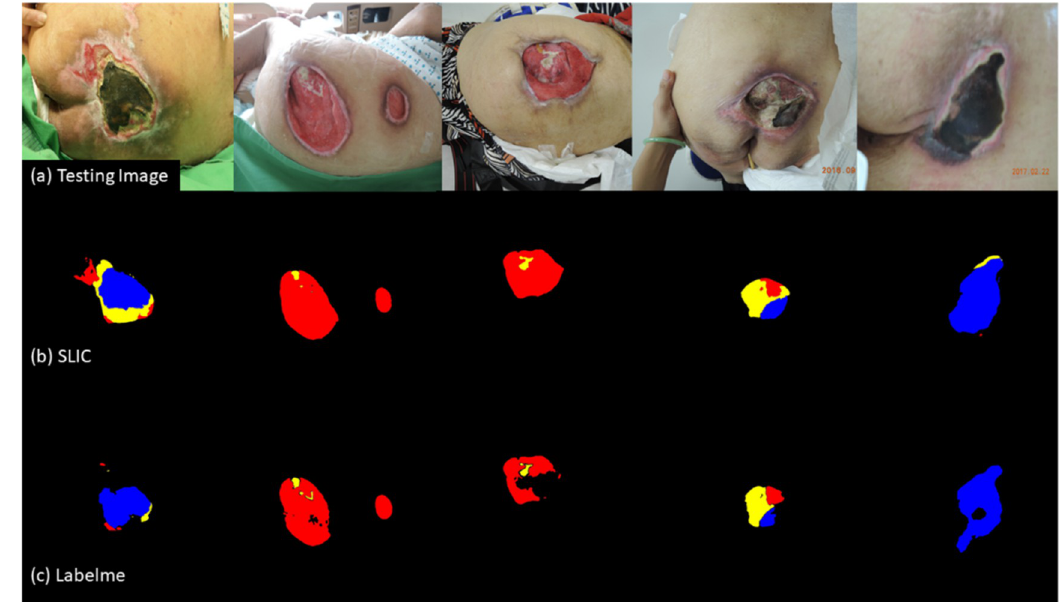
Fig 3. Tissue classification performance on testing images of U-Net with different labeling methods. (a) Original images of pressure ulcers. (b) Classifications of Model 4 (SLIC). (c) Classifications of Model 3 ( Labelme ). Granulation: red; Slough: yellow; Eschar: